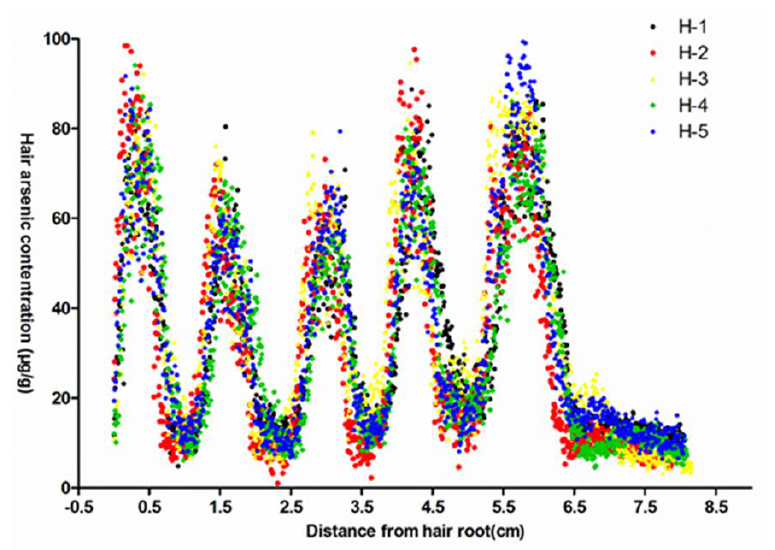
Figure 1. Arsenic concentration profiles of five hairs collected from the occipital region of patient No. 1. H-1 to H-5 represented hair samples 1 to 5, respectively.